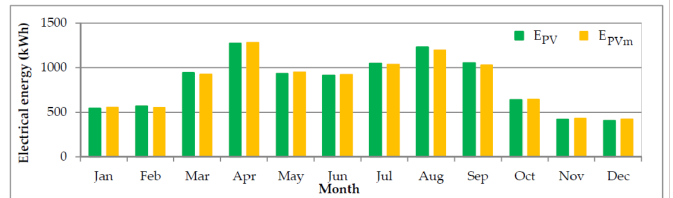
Figure 16. The monthly electrical energy output of the 9.6 kWp photovoltaic platform obtained through Trnsys17 numerical simulations (E PV ) and measured by the monitoring system (E PVm ).